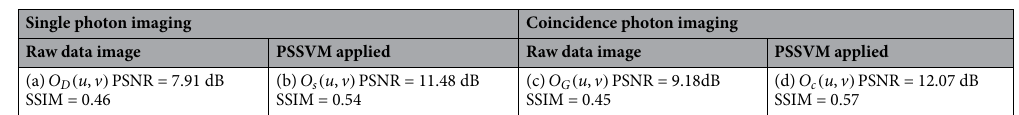
Table 1. Performance of image generation using raw data. Labels (a–d) correspond to those in Fig. 5.